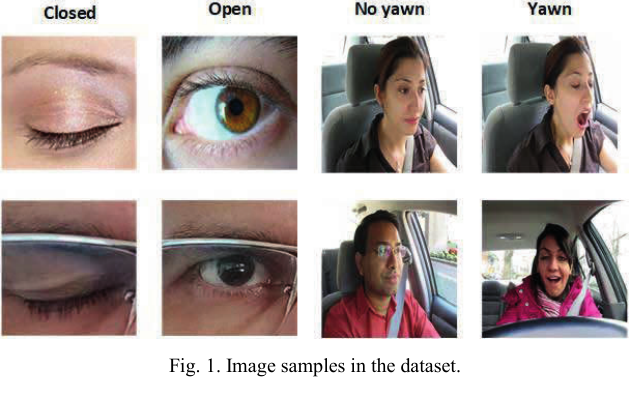
Fig. 1. Image samples in the dataset.